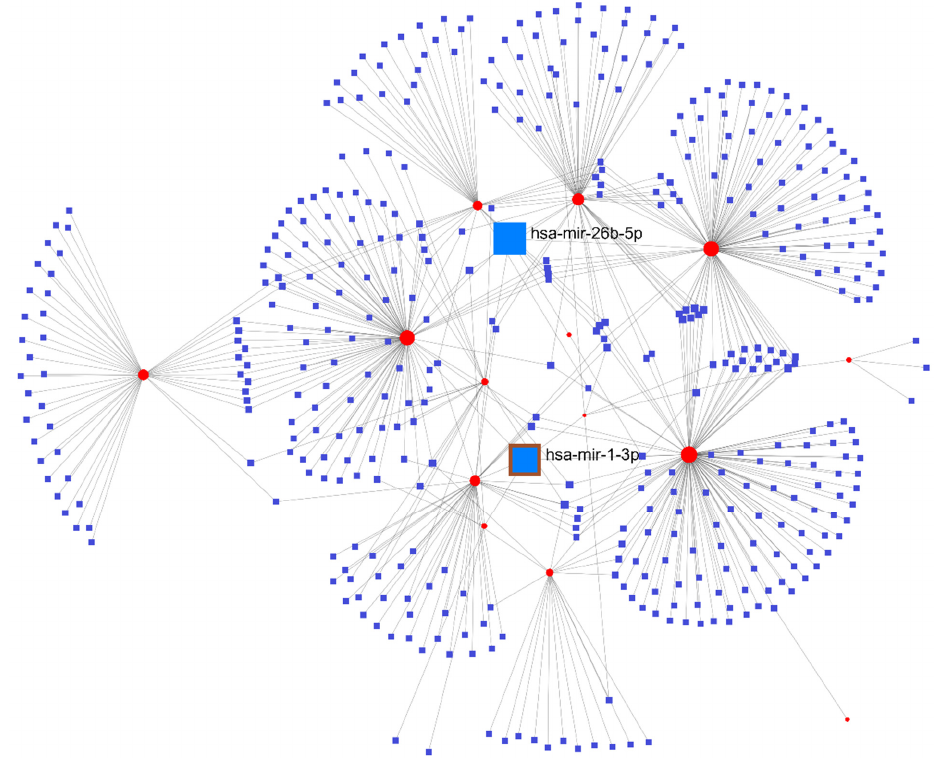
Figure 16. The network of miRNA-hub genes. Circles represent the hub gene, while the squares represent miRNAs targeting the hub genes.